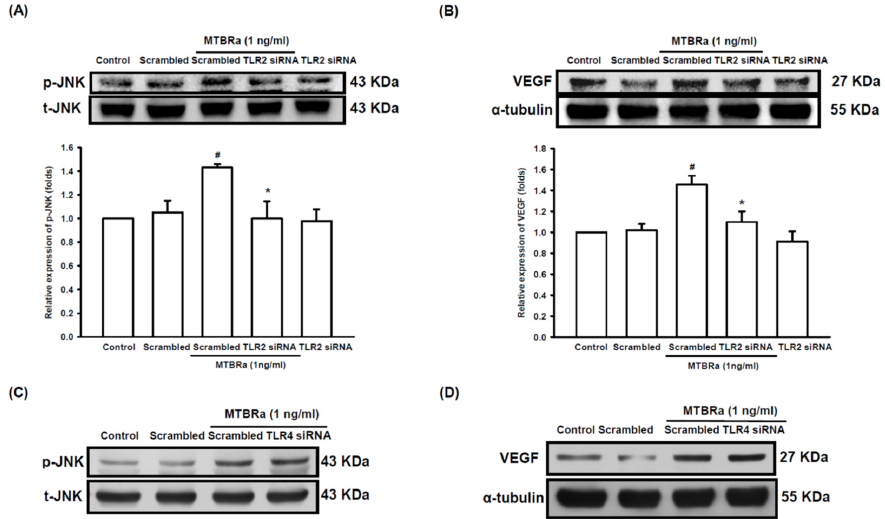
Figure 6. MTBRa activates TLR2/JNK pathway to increase VEGF expression in human PMC cells. MeT-5A cells were transfected with scrambled siRNA and ( A , B ) TLR2 siRNA (25 nM) or ( C , D ) TLR4 siRNA (25 nM) for 48 h, then treated with or without MTBRa stimulation. JNK phosphorylation and VEGF expression were determined by Western blotting after MTBRa stimulation for 15 min and 24 h, respectively. Data are representative of three separate experiments. # p < 0.05 compared with the scrambled siRNA group; * p < 0.05 compared with MeT-5A cells transfected with scrambled siRNA, followed by MTBRa treatment group. MTBRa, Mycobacterium tuberculosis H37Ra; VEGF, vascular endothelial growth factor; PMC, pleural mesothelial